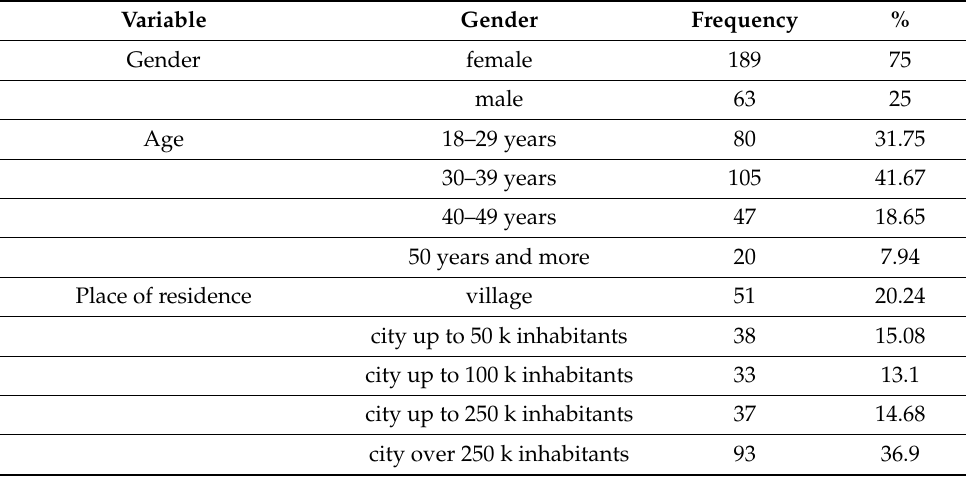
Table 1. Characteristics of participants ( n =